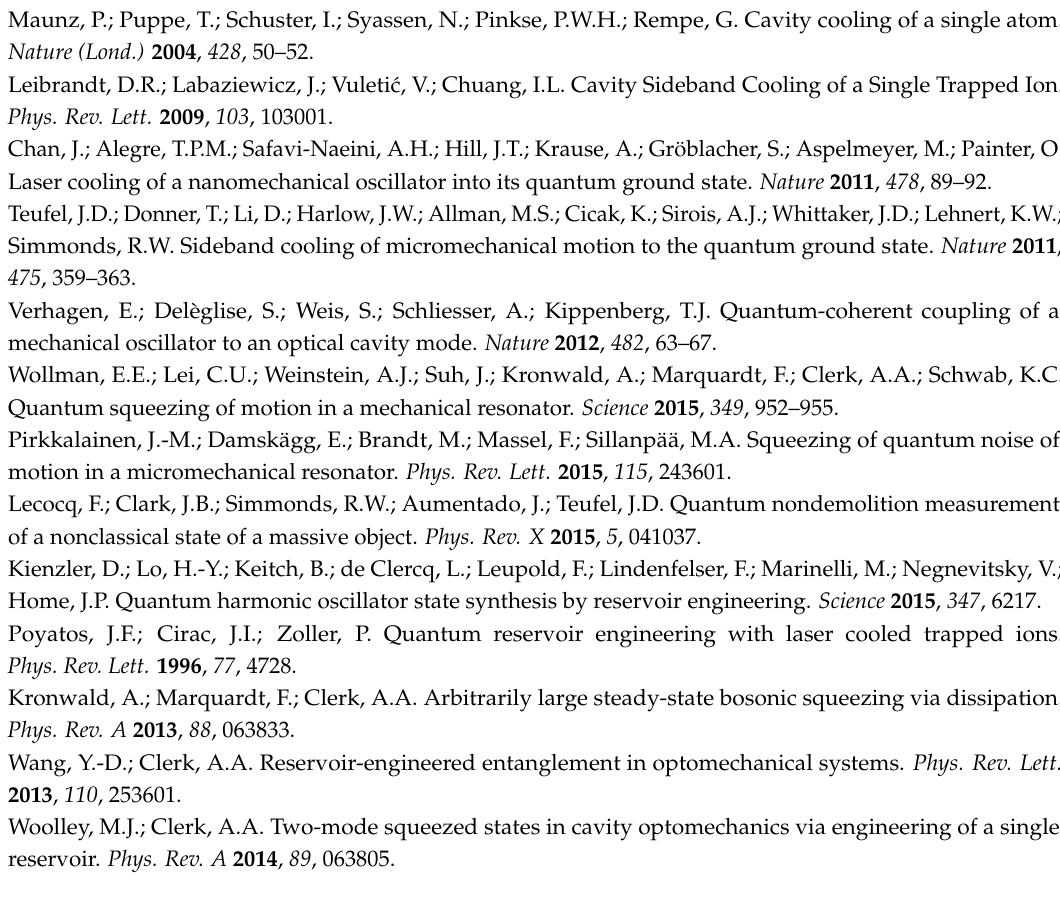
Figure 1. Wigner function W ( q , p ) = 1 values ζ = 0.99 ( left ), ζ = 0.9 ( centre ), ζ = 0.7 ( right